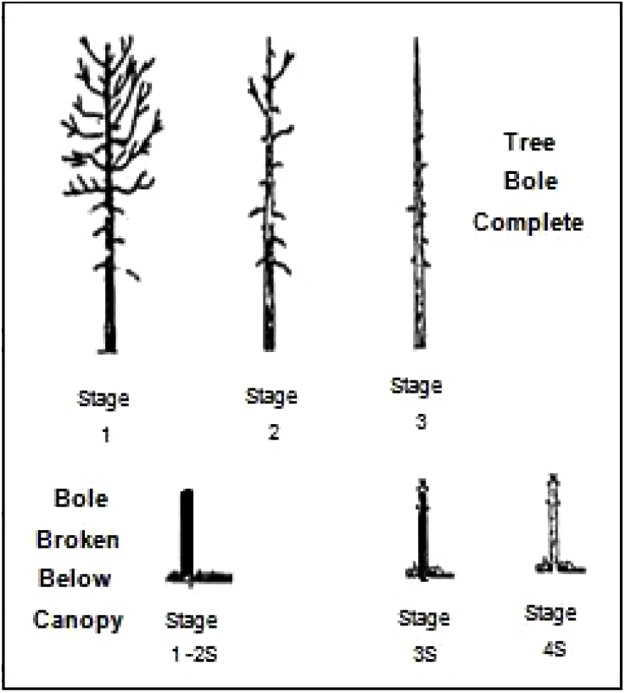
Visual representation of decay stages for snags and stumps.